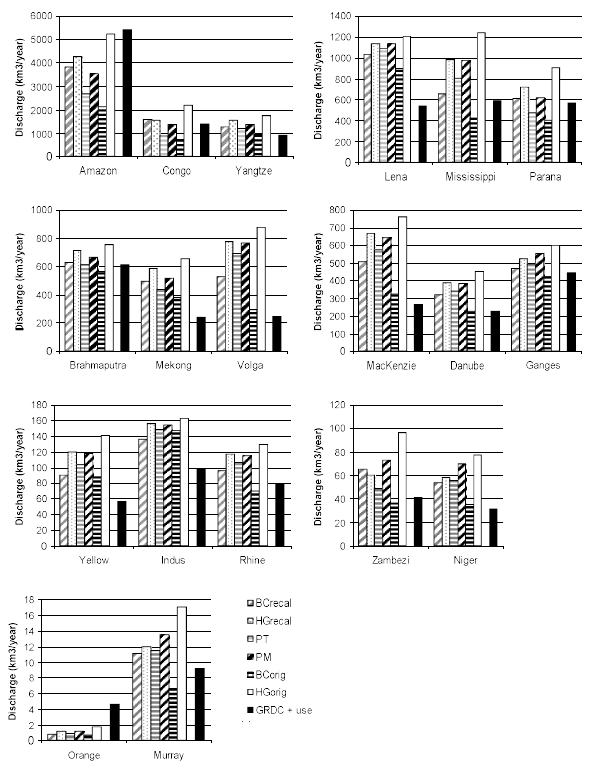
Fig. 10. Long-term average annual basin discharge (km 3 yr − 1 ) for 19 large river basins derived with PCRGLOB-WB forced with the CFSR dataset where potential evaporation was calculated using one of the six different PET methods (group of bars on the right for each river). As a reference long-term average corrected observed GRDC basin discharge has been included (black; periods do not completely overlap due to limited data